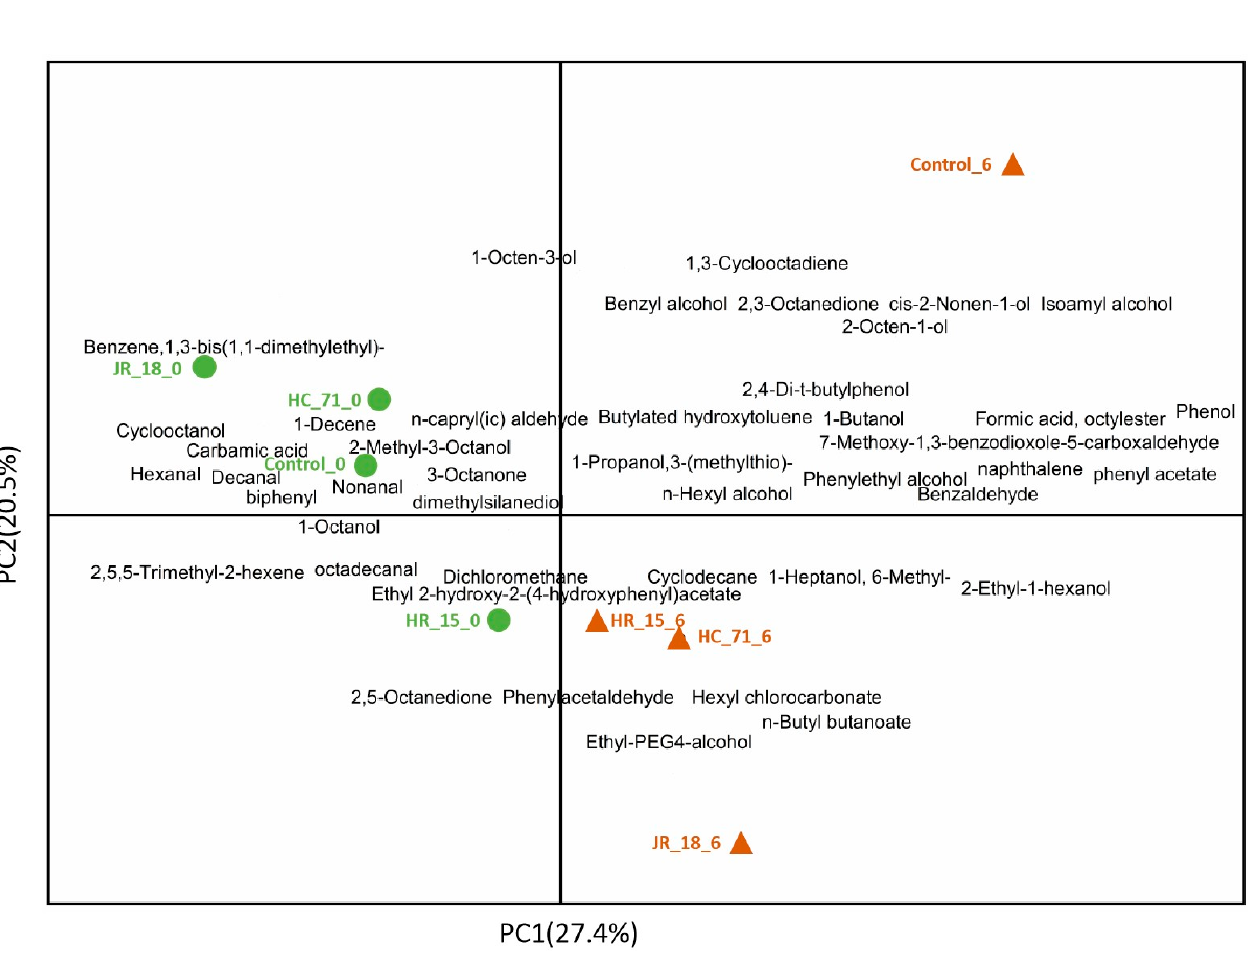
Figure 7. The PCA score plots of the volatile compounds in the different treated groups. The control group (Con_0: refrigerate for zero days; Con_6: refrigerate for six days) was fed with common feed, and the experimental groups (HR-15 (HR-15_0, HR-15_6), JR-18 (JR-18_0, JR-18_6), and HC-71 (HC-71_0, HC-71_6)) were fed with the supplemented S. putrefaciens feed.